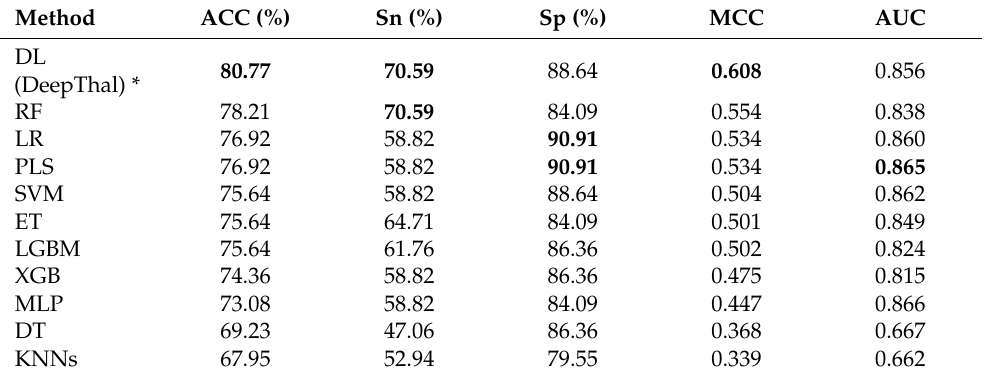
Table 5. Independent test results of different ML-based predictors in the independent test dataset.